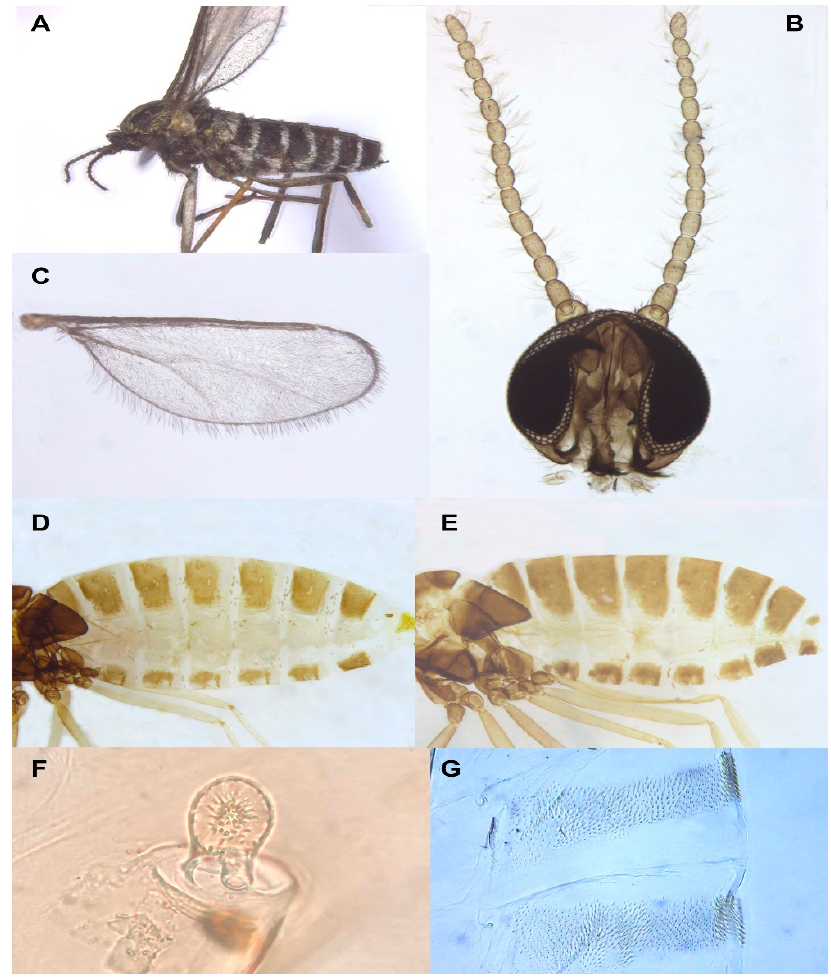
Figure 3. Ruschiola spp. ( A ) R. namaqua , habitus. ( B ) R. succulenta , head. ( C ) R. namaqua , wing. ( D ) R. succulenta , female abdomen. ( E ) R. succulenta , male abdomen. ( F ) R. succulenta , pupal prothoracic spiracle, encasing looped trachea. ( G ) R. succulenta , pupal abdominal segments, inset.